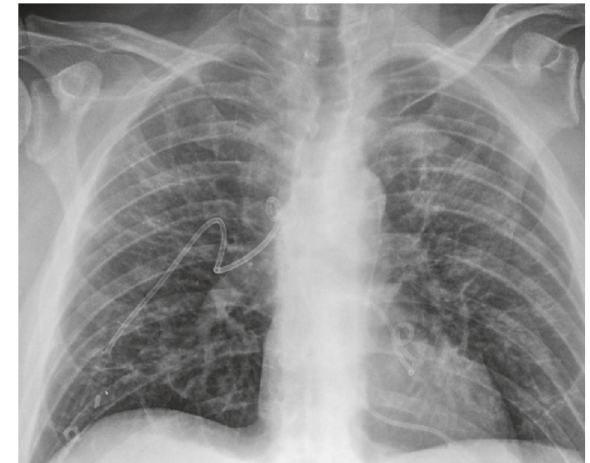
Figure 3: Anteroposterior chest radiograph confirming chest tube